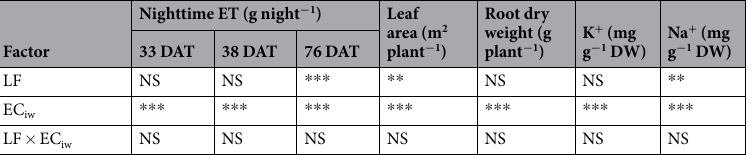
Table 2. Output of the two–way analysis of variance (ANOVA) for nighttime evapotranspiration (ET) at 33, 38 and 76 days after transplanting (DAT), leaf area, root dry weight and K + and Na + concentrations of hot